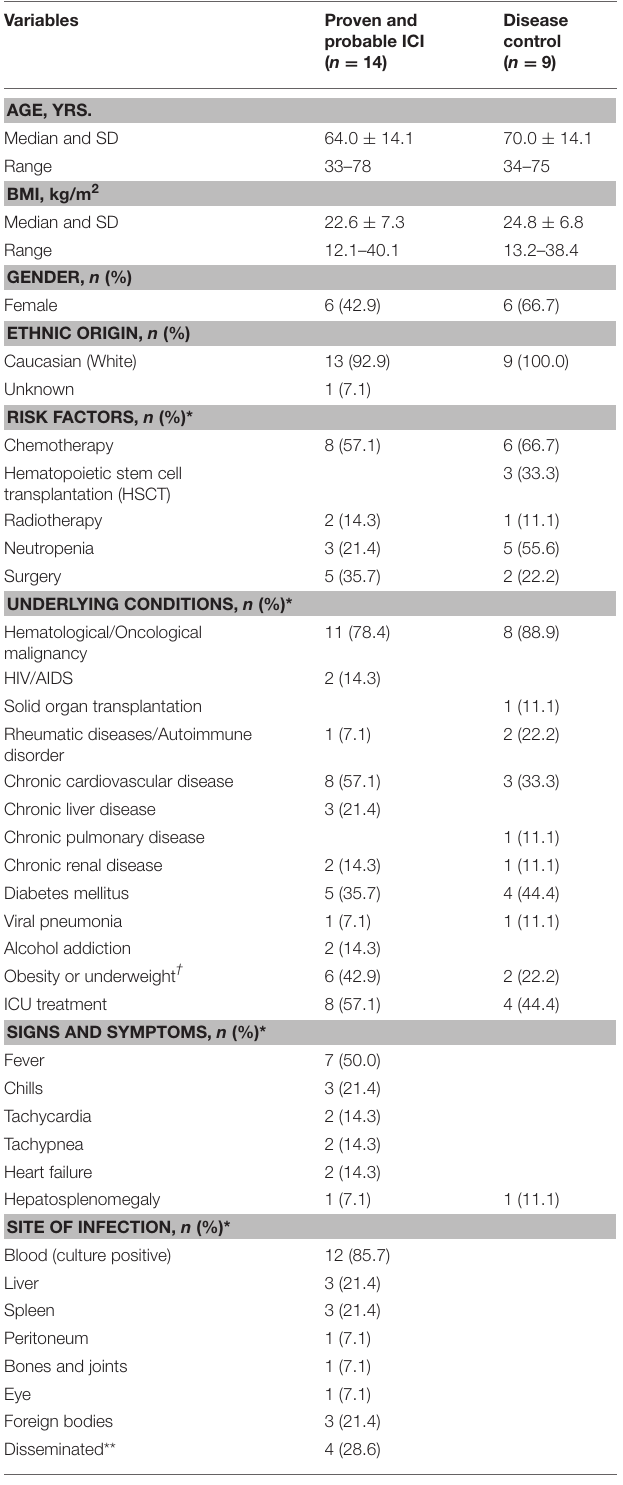
TABLE 1 | Baseline characteristics of study